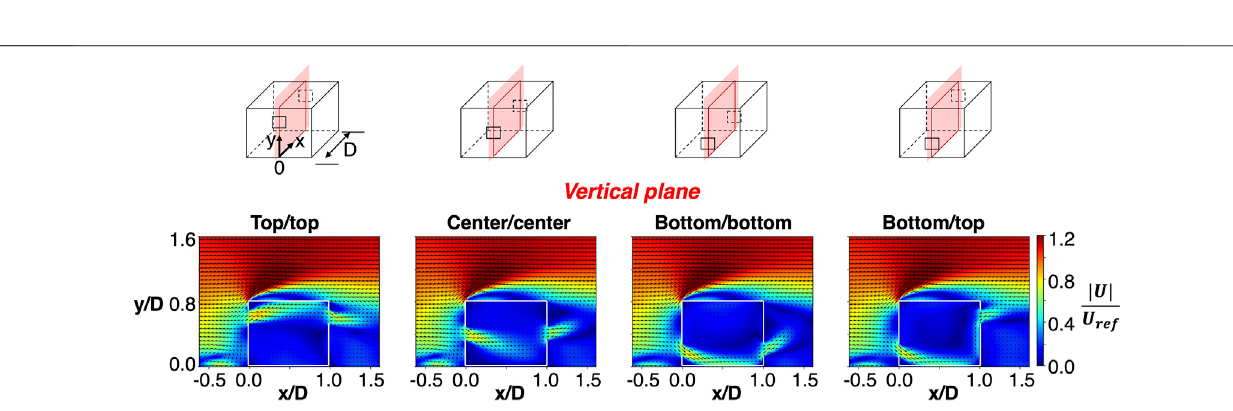
Frontiers in Built Environment |